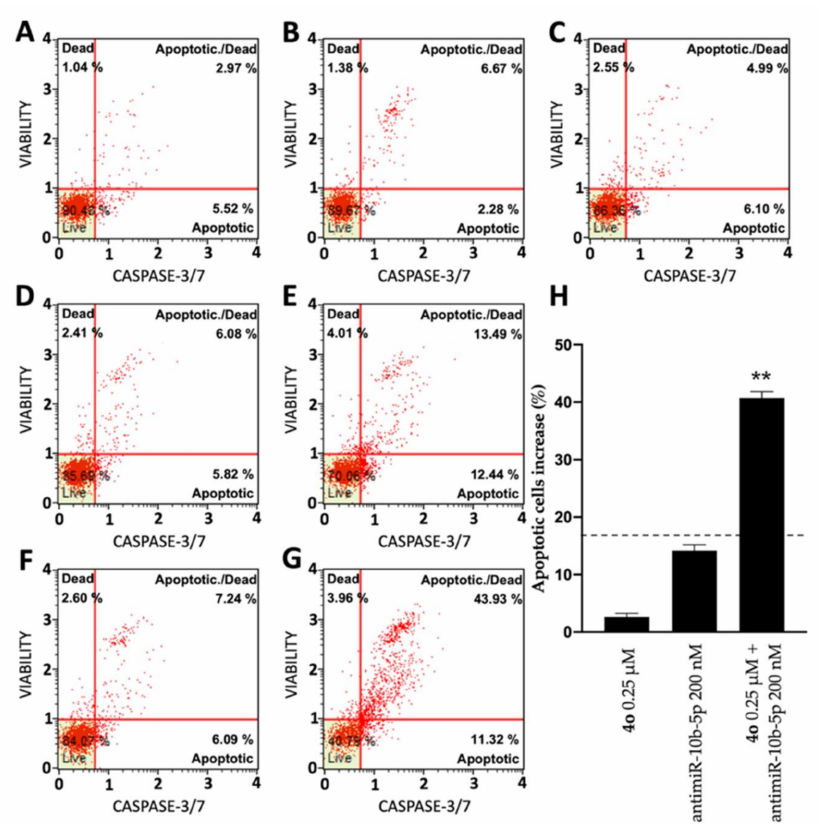
Figure 7. Effects of compound 4o and antimiR-10b-5p on U251 apoptosis: Caspase 3/7 assay. Apop- tosis was assayed after 72 h culture. ( A ) Untreated control cells; ( B ) cells treated with DMSO; ( C ) cells treated with 0.25 µ M compound 4o ; ( D ) cells treated with lipofectamine; ( E ) cells treated with 200 nM antimiR-10b-5p; ( F ) cells treated with DMSO and lipofectamine; ( G ) cells treated with combined administration of 0.25 µ M compound 4o and antimiR-10b-5p. ( H ) Summary including results rep- resenting % of apoptotic cells of U251 cultures treated as indicated. Results represent mean ± SD ( n = 3). The dotted line represents the sum of the values obtained with single administrations of the compounds. p < 0.01 (**; highly significant).